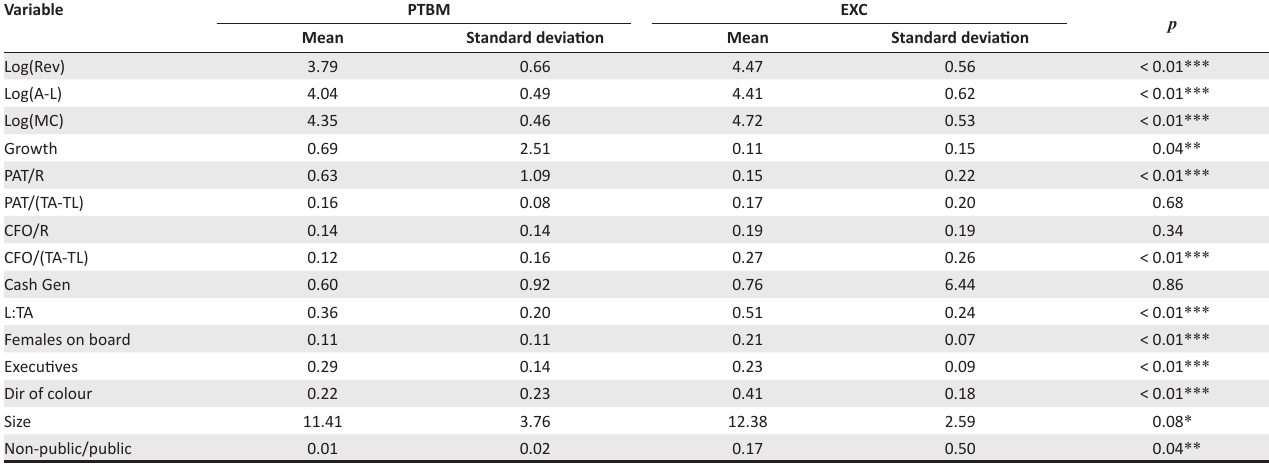
TABLE 4: Results of the mixed-model repeated measures ANOVA.